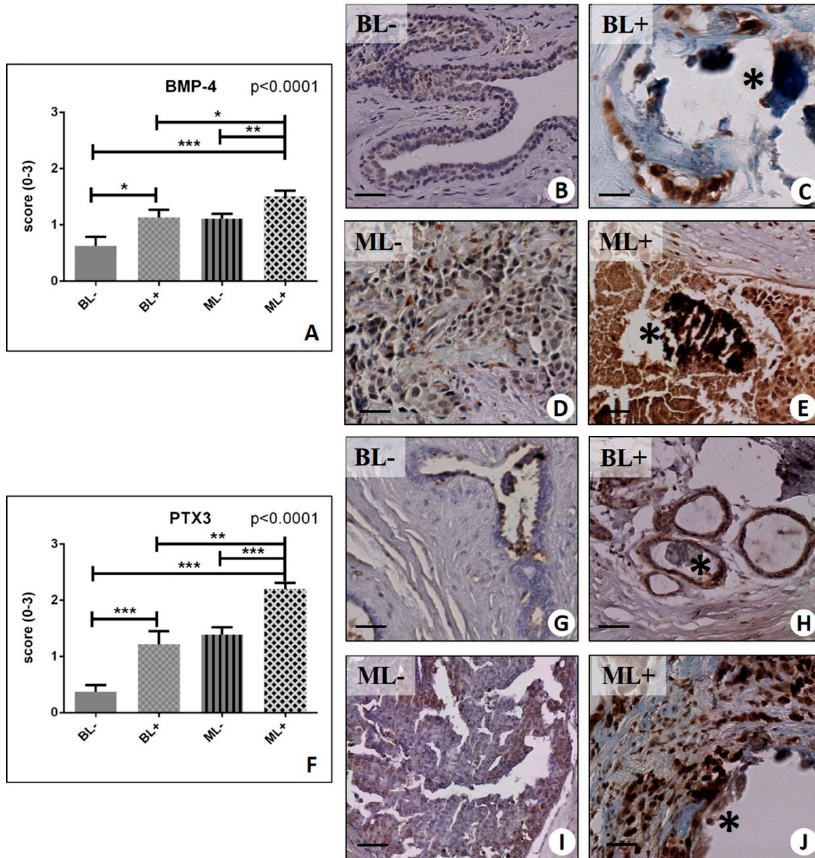
Figure 4. Immunohistochemical evaluation of BMP-4 and Pentraxin 3 PTX3. ( A ) Graph shows the expression of BMP-4 in BL − , BL+, ML − , and ML+ groups. ( B ) No/rare BMP-4-positive cells in fibroadenoma. ( C ) Microcalcification (asterisk) surrounded by BMP-4-positive cells in fibroadenoma. ( D ) Infiltrating breast carcinoma with some BMP-4-positive cells. ( E ) Image shows several BMP-4-positive cells next to calcifications (asterisk) in infiltrating carcinoma. ( F ). Graph shows the expression of PTX3 in BL − , BL + , ML − , and ML + groups. ( G ) Rare PTX3-positive cells in fibroadenoma. ( H ) Several PTX3-positive cells close to microcalcification (asterisk) in fibroadenoma. ( I ) Infiltrating breast carcinoma with some PTX- positive cancer cells. ( J ) Image displays several PTX3-positive cells close to microcalcification (asterisk) in infiltrating carcinoma... (* p < 0.05; ** p < 0.01; *** p < 0.001). Scale bar represents 100 µ m in all